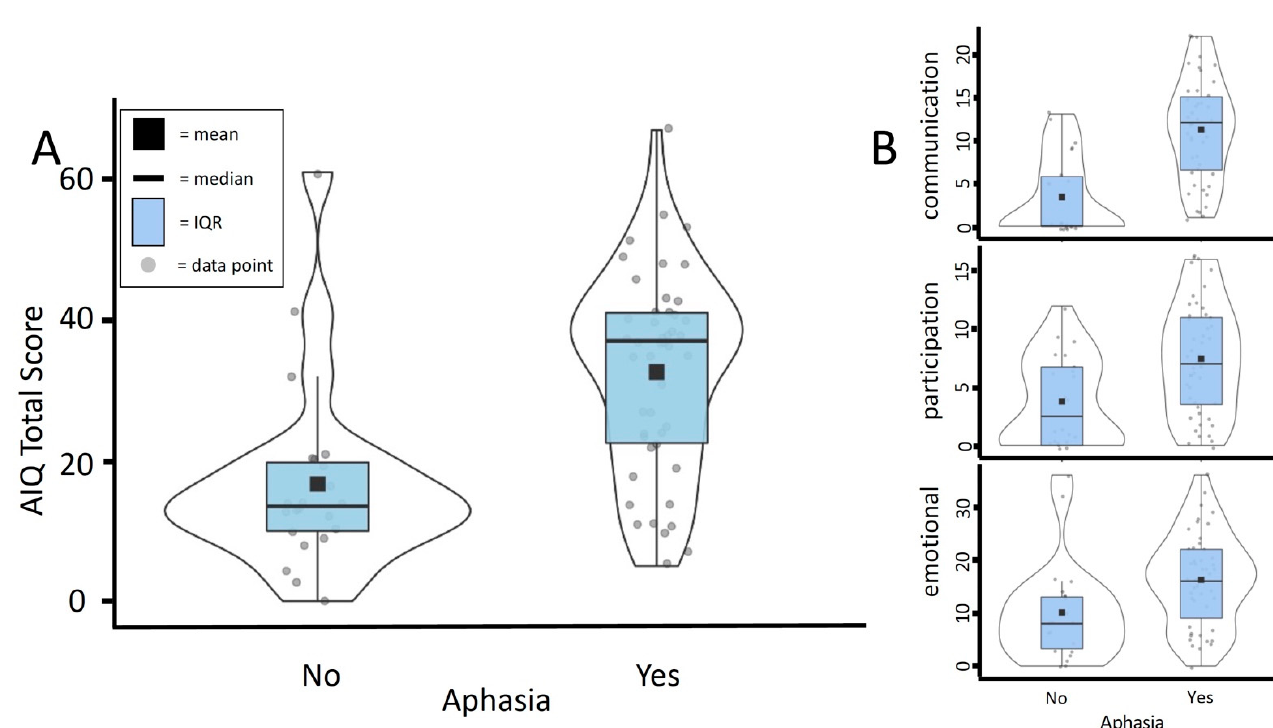
Figure 4. Violin Plot of the Scores of PWA compared to stroke survivors without aphasia on the AIQ-21-GR. ( A ) shows the overall scores of PWA compared to stroke survivors without aphasia. ( B ) shows the results between the scores of PWA and people without aphasia on the three domains of the AIQ-21-GR.